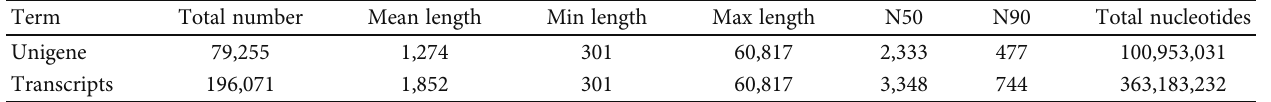
Table 3: Summary of de novo assembly results of the muscular transcriptome.